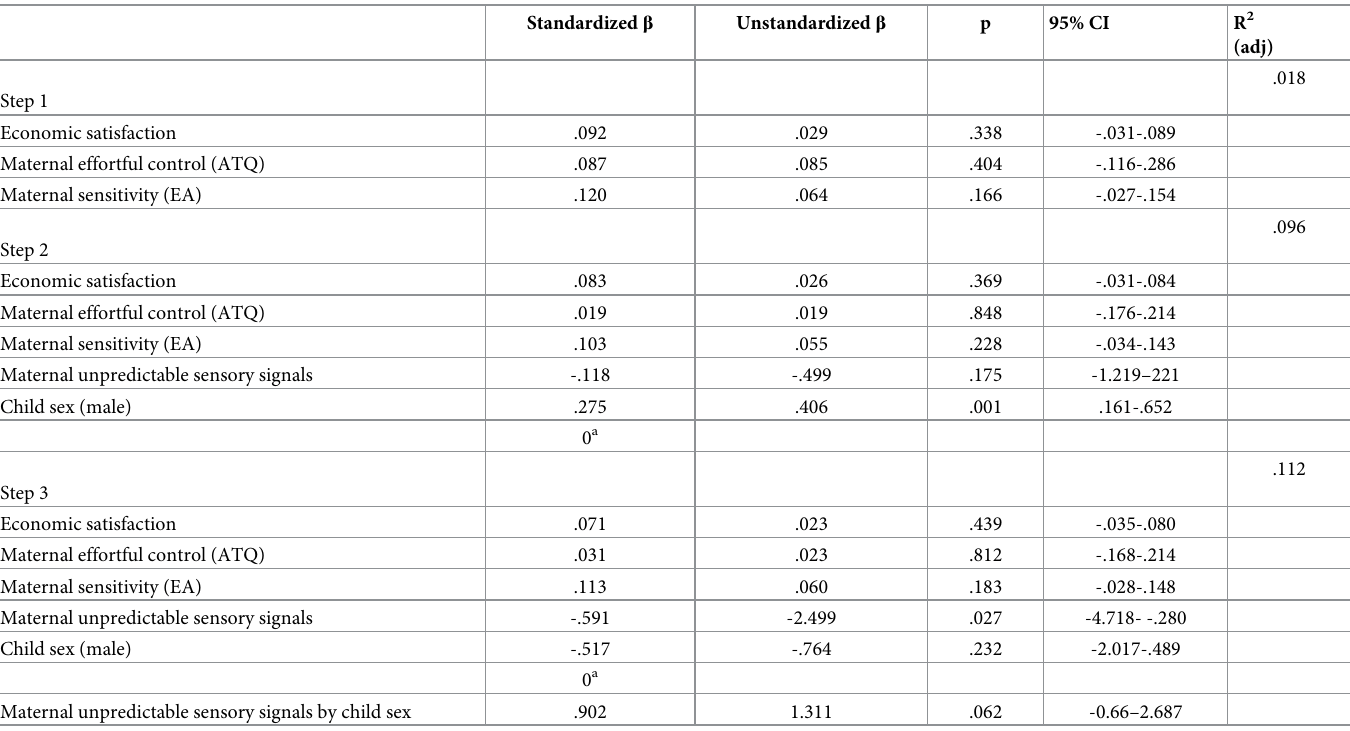
Table 4. Standard linear regression for child effortful